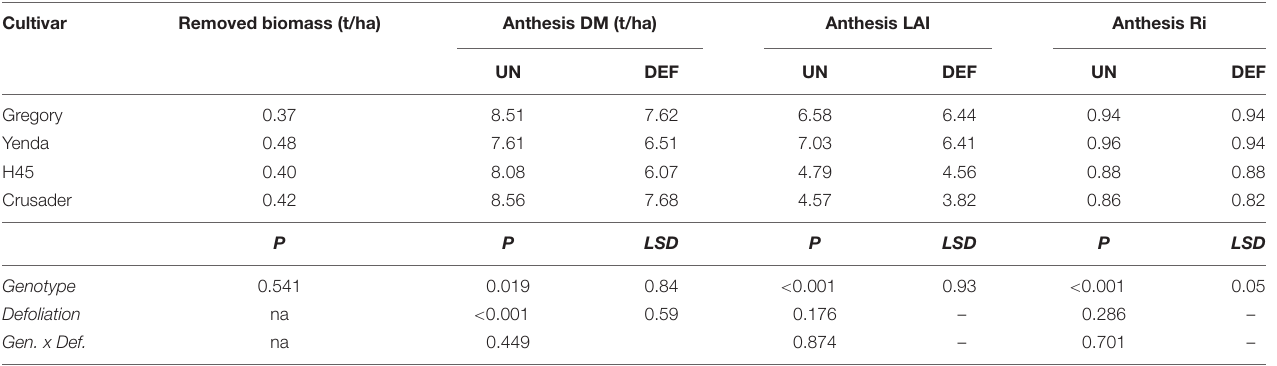
TABLE 6 | Biomass removed and subsequent biomass, leaf area index (LAI), and radiation interception (R i ) at anthesis of four spring wheat cultivars following defoliation at GS26 (DEF) compared to an undefoliated control (UN) (Experiment 3 – Brookstead, 2013). Cultivar Removed biomass (t/ha) Anthesis DM (t/ha) Anthesis LAI Anthesis Ri UN